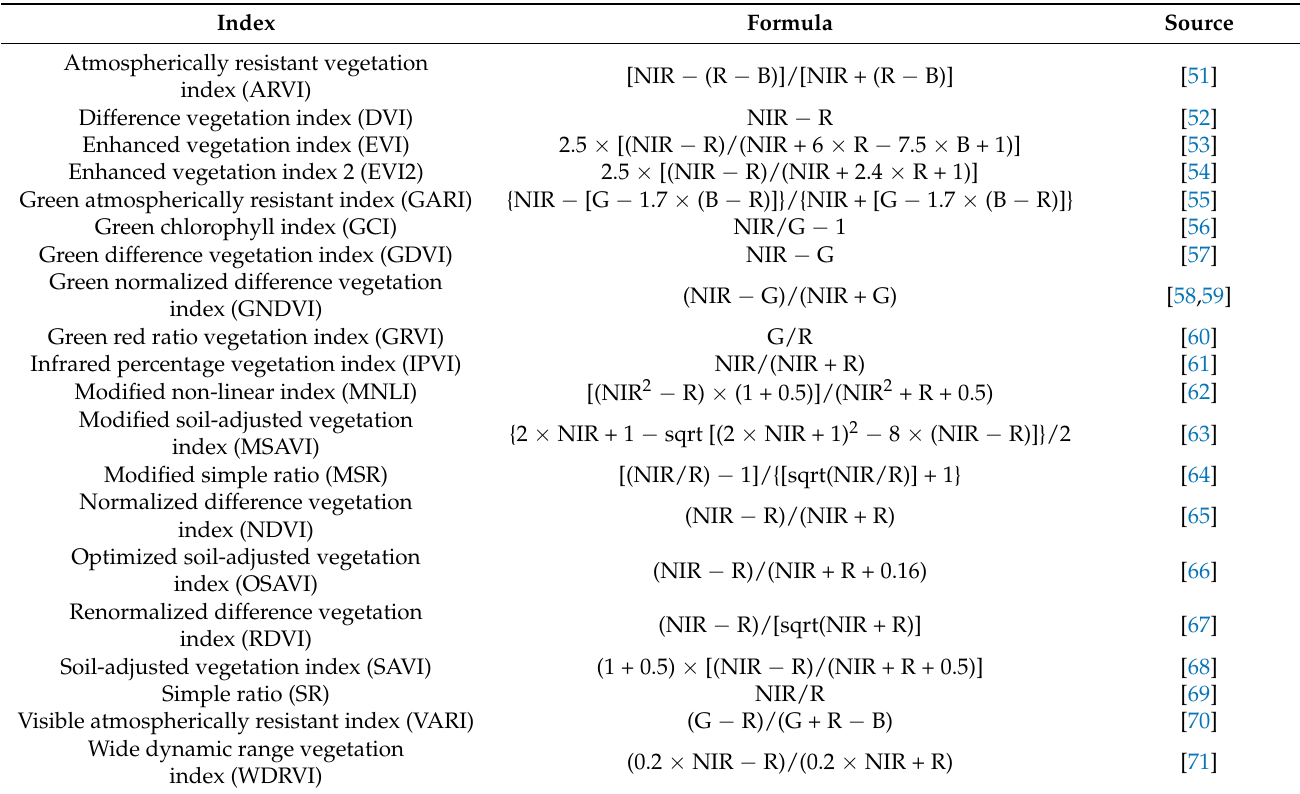
Table 4. Spectral vegetation indices examined in this